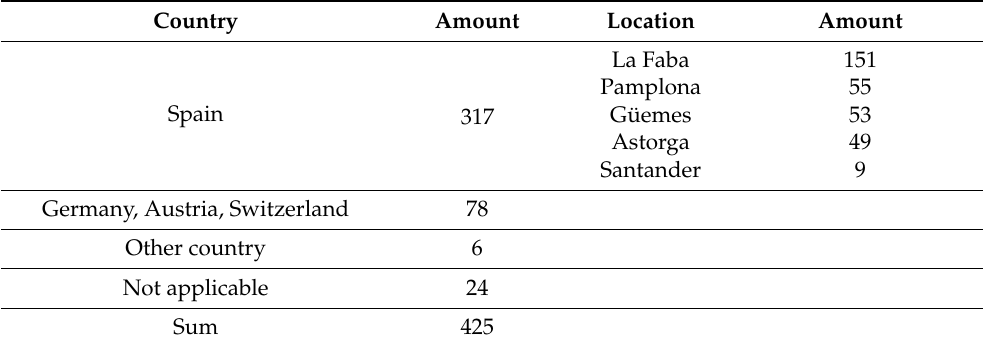
Table 1. Composition of the Sample of German-Speaking Pilgrims by